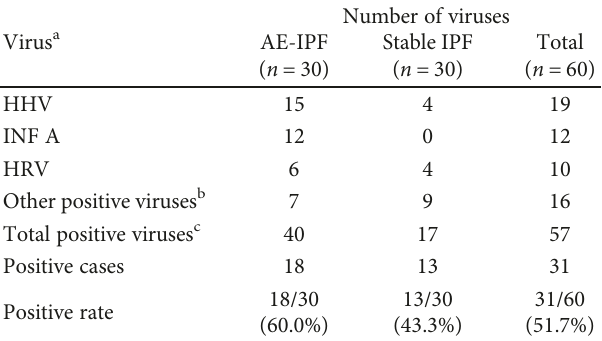
Table 5: Viruses in nasopharyngeal swabs of IPF patients. Virus